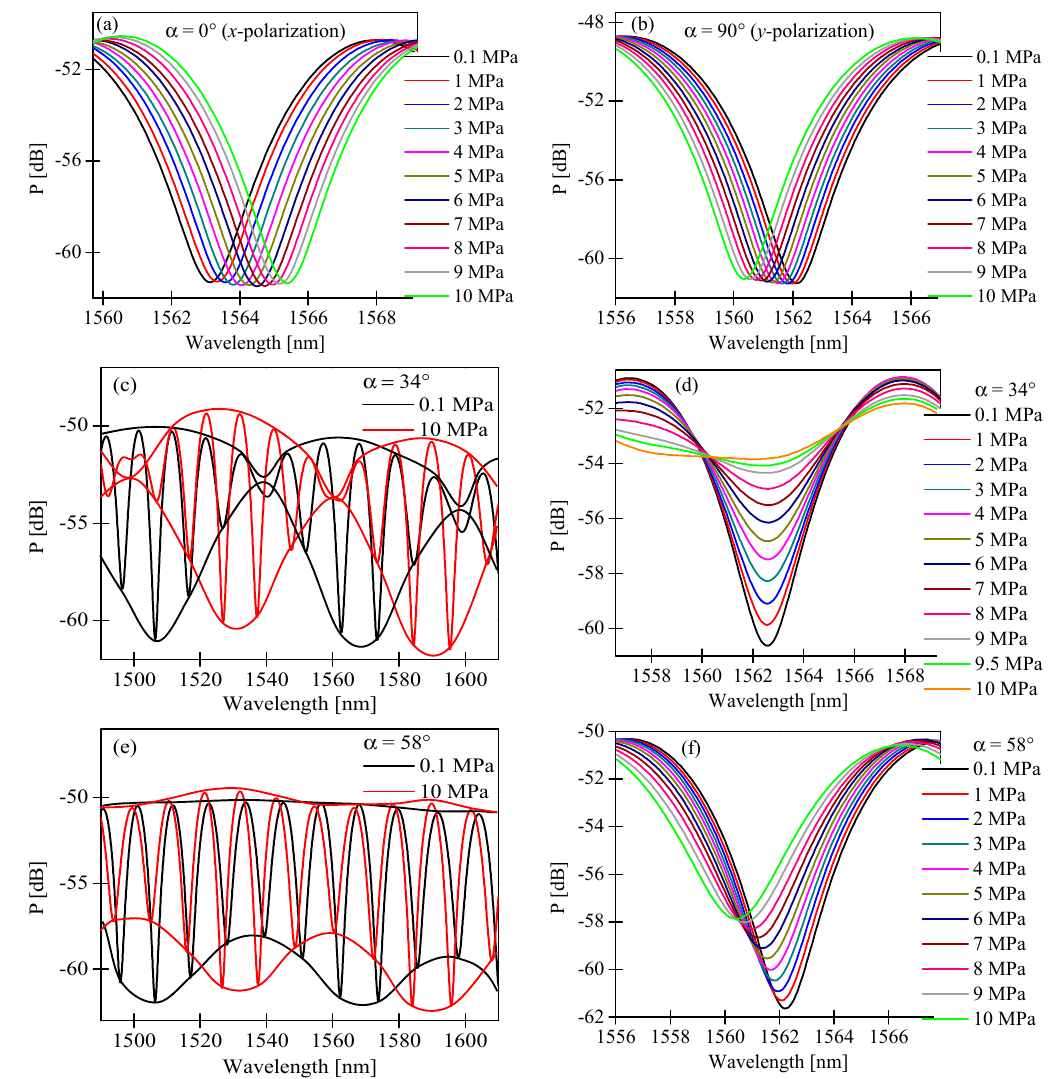
Figure 7. Evolution of the intermodal interference fringe with the intensity minimum close to 1563 nm registered for increasing hydrostatic pressure in the range of 0.1–10 MPa for the azimuth of the input polarization state set at α = 0° ( a ); α = 90° ( b ); α = 34° ( d ); and α = 58° ( f ); and output spectrograms registered in the range from 1490 nm to 1610 nm for selected values of hydrostatic pressure showing the displacement of the envelope for the azimuth of the input polarization state set at α = 34° ( c ); and α = 58° ( e ).